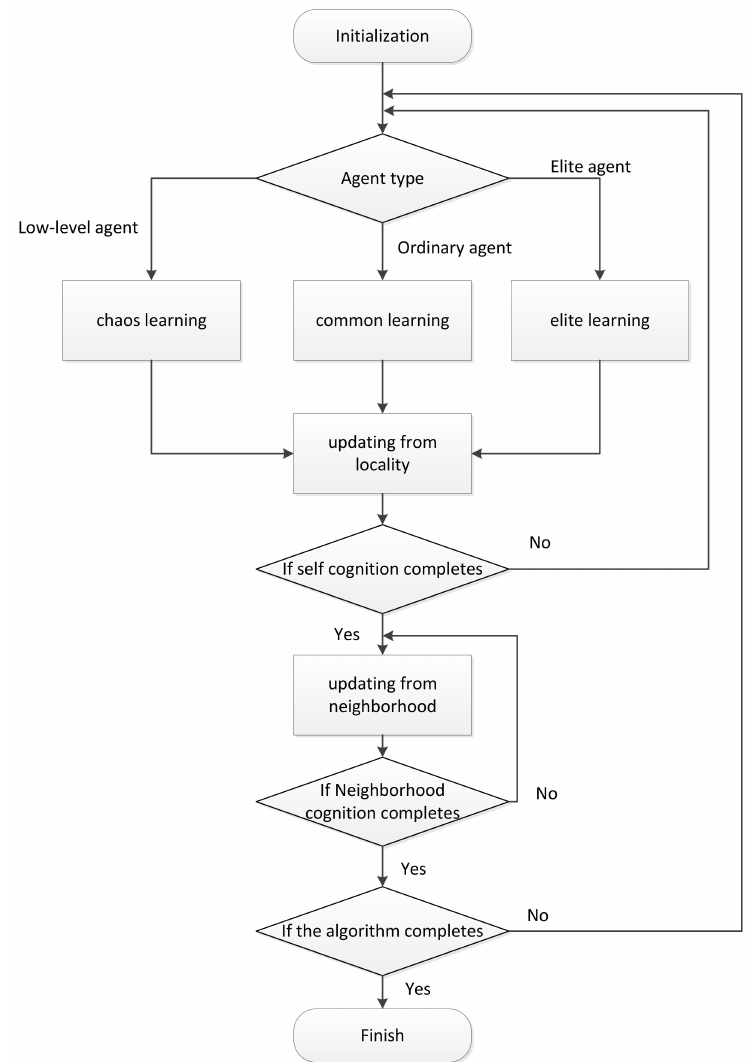
Figure 4. Basic steps of the multi-agent hybrid social cognitive optimization (MAHSCO)